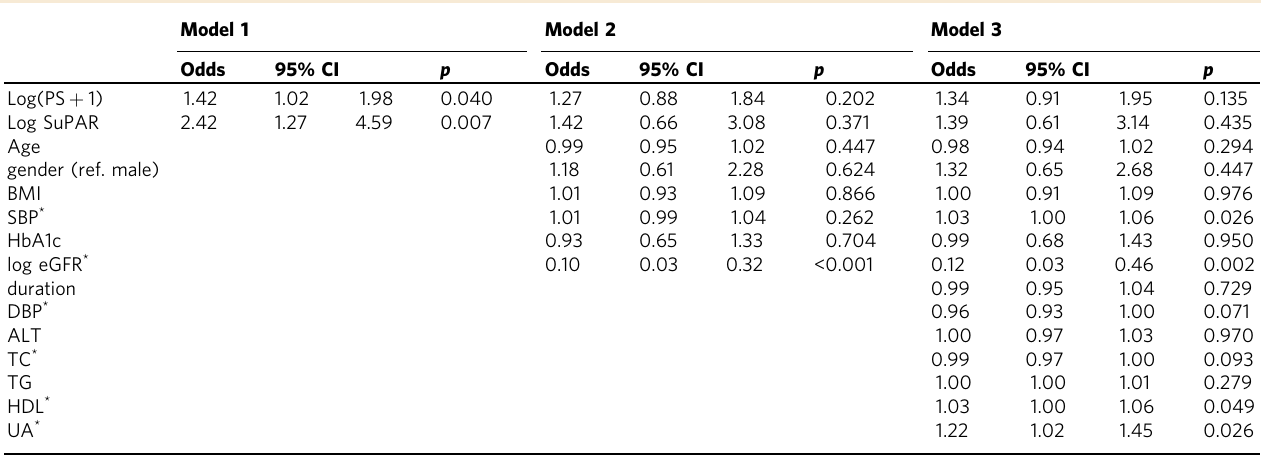
Table 4 Logistic regression